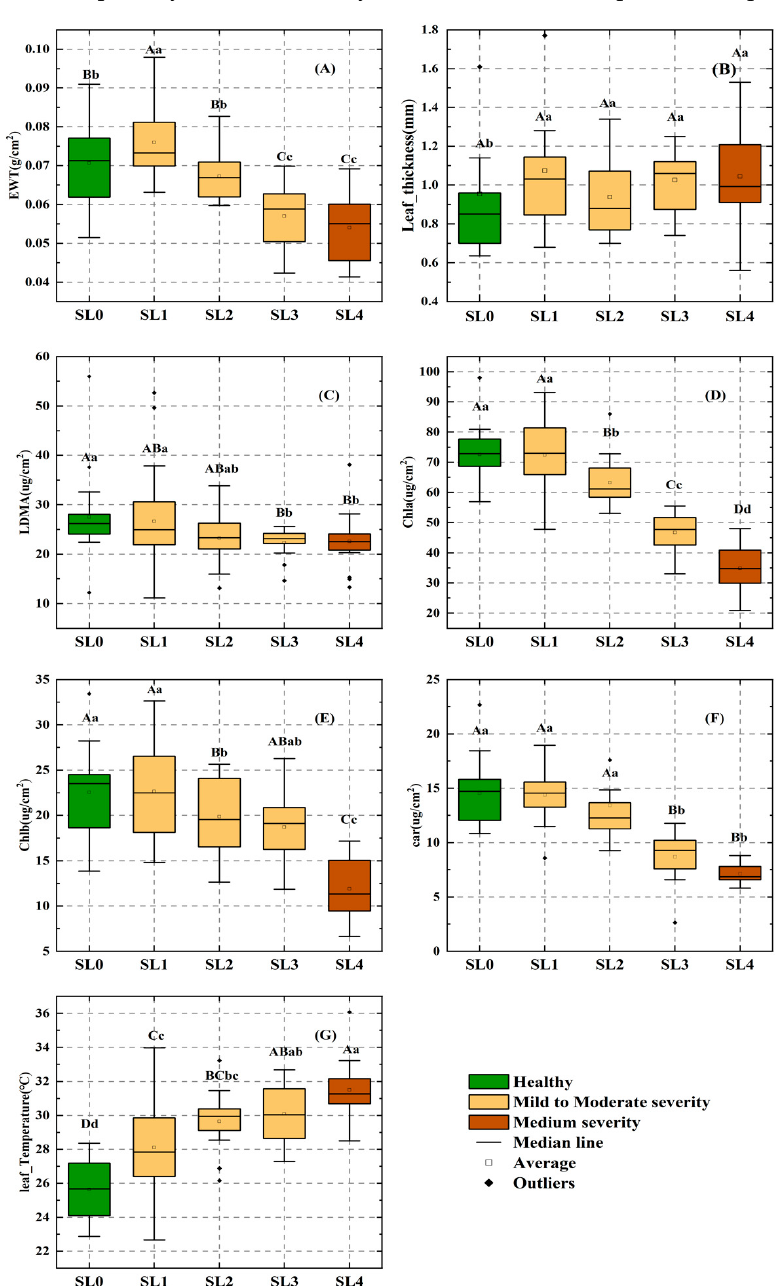
Figure 4. Variation in physiological indicators of cotton leaves at different levels of disease. ( A ) Equivalent water thickness, ( B ) leaf thickness, ( C ) dry matter mass, ( D ) chlorophyll a content, ( E ) chlorophyll b content, ( F ) carotenoid content, ( G ) leaf temperature. Dots outside each box line plot indicate outliers. Different lowercase and capital letters in the figure indicate significant differences at the level of 0.05 and 0.01, respectively. Letters that are the same indicate non-significant differences, while different letters indicate significant differences. Data marked as AB indicate that there are no significant differences between these data and data marked as A or